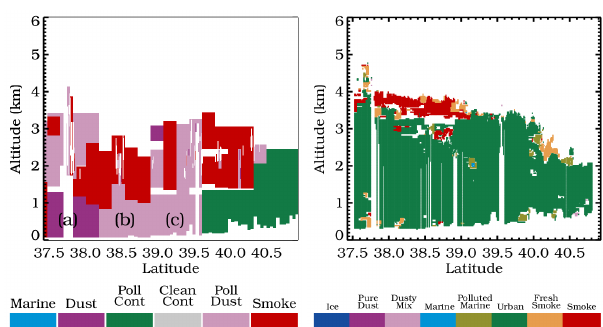
Fig. 6. Aerosol classification masks for CALIOP (left) and HSRL-1 (right) for a daytime scene near Washington DC on 4 August 2007. Transit time for the HSRL aboard the B200 was 50min for this scene. CALIPSO transited the same scene in 1.0min. In this case, the flight segment ended approximately 13min before the CALIPSO overpass